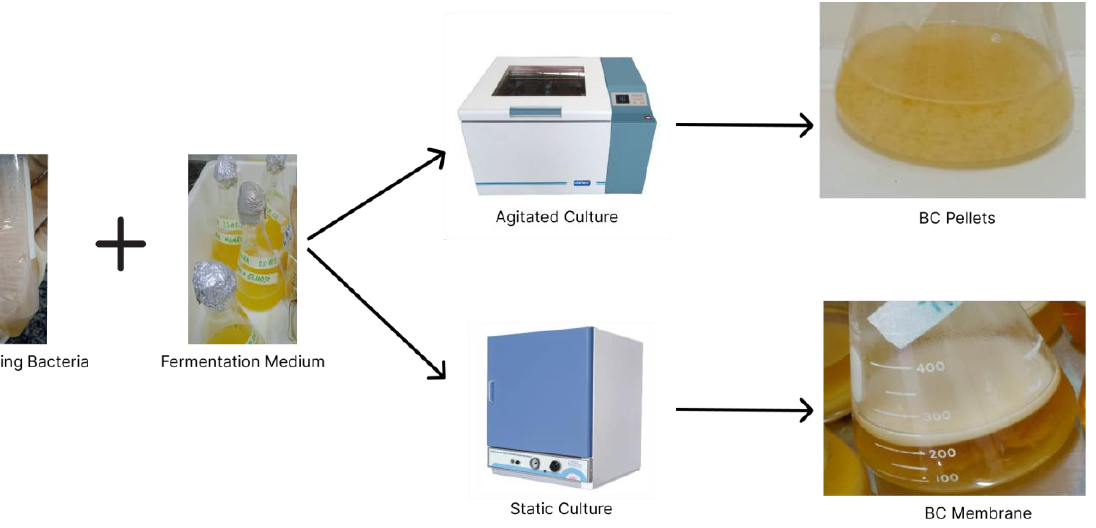
Figure 2. BC production process.